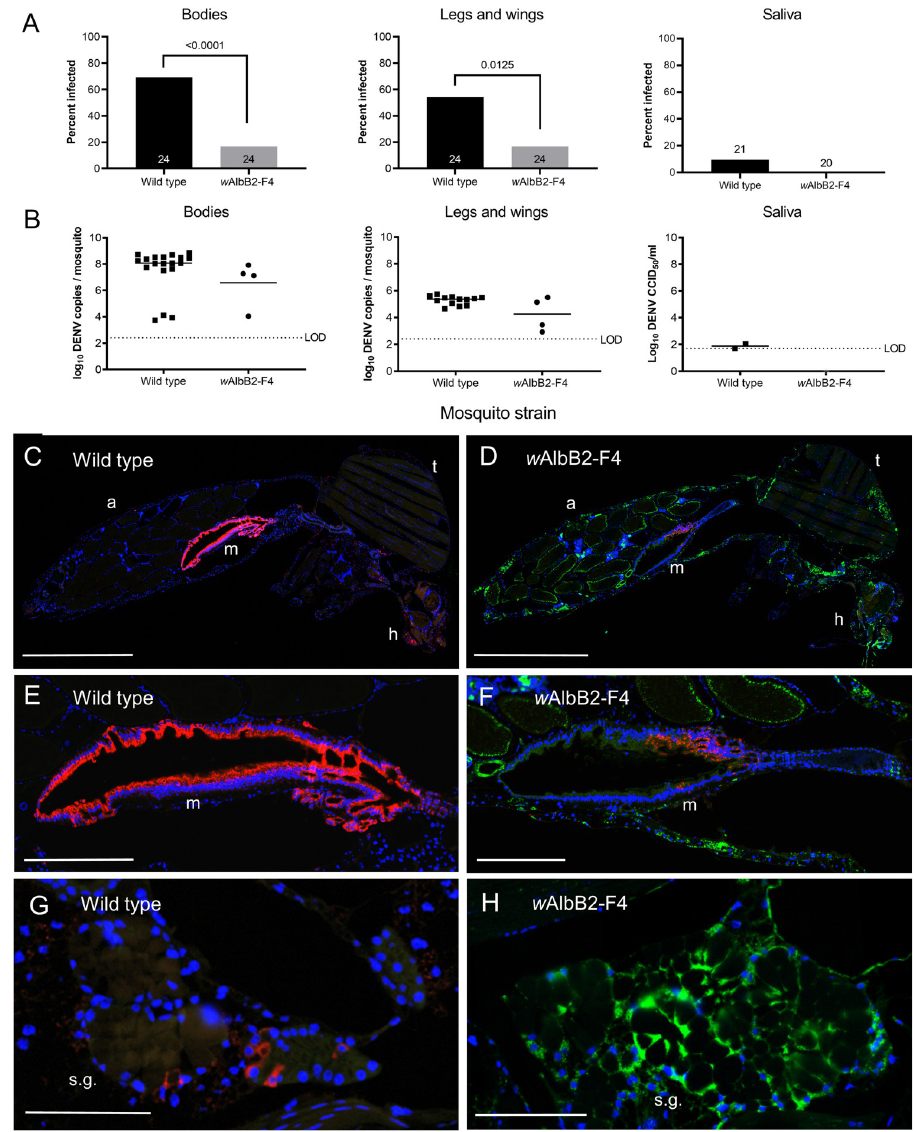
Fig 2. Wolbachia inhibit dengue 2 infections in Ae . aegypti w AlbB2-F4 mosquitoes. (A) DENV-2 virus prevalence in the bodies, legs and wings, and saliva of Ae . aegypti w AlbB2-F4 and wild type mosquitoes 14 d after feeding on a blood meal containing 1 × 10 6.6 CCID 50 /ml (in C6/36 cells) of DENV-2 virus. P values are included for comparisons with significant differences in mosquito infection rates between w AlbB2-F4 and wild type mosquitoes (Fisher’s Exact test). (B) DENV-2 infection intensity in mosquitoes in A. Virus copy numbers were determined from bodies, legs and wings and saliva samples using quantitative reverse-transcriptase PCR (qRT-PCR). P values are shown for comparisons with significant different median virus copy numbers between w AlbB2-F4 and wild type mosquitoes (Mann-Whitney test). (C) Example whole body midsagittal section from a wild type mosquito dual stained for Wolbachia (green) and DENV-2 (red). (D) Whole body section of a w AlbB2-F4 female showing restriction of virus to the midgut. (E-F) High resolution images of midguts from wild type and w AlbB2-F4 mosquitoes showing lower DENV-2 staining density in the w AlbB2-F4 midgut. (G-H) High resolution images of salivary glands from wild type and w AlbB2-F4 mosquitoes showing dense Wolbachia infection and absence of DENV-2 infection in the latter. a, abdomen. h, head. LOD, limit of detection. m, midgut. s.g., salivary glands. t, thorax. Scale bars: C-D, 1 mm. E-F, 0.25 mm, G-H: 0.10 mm.